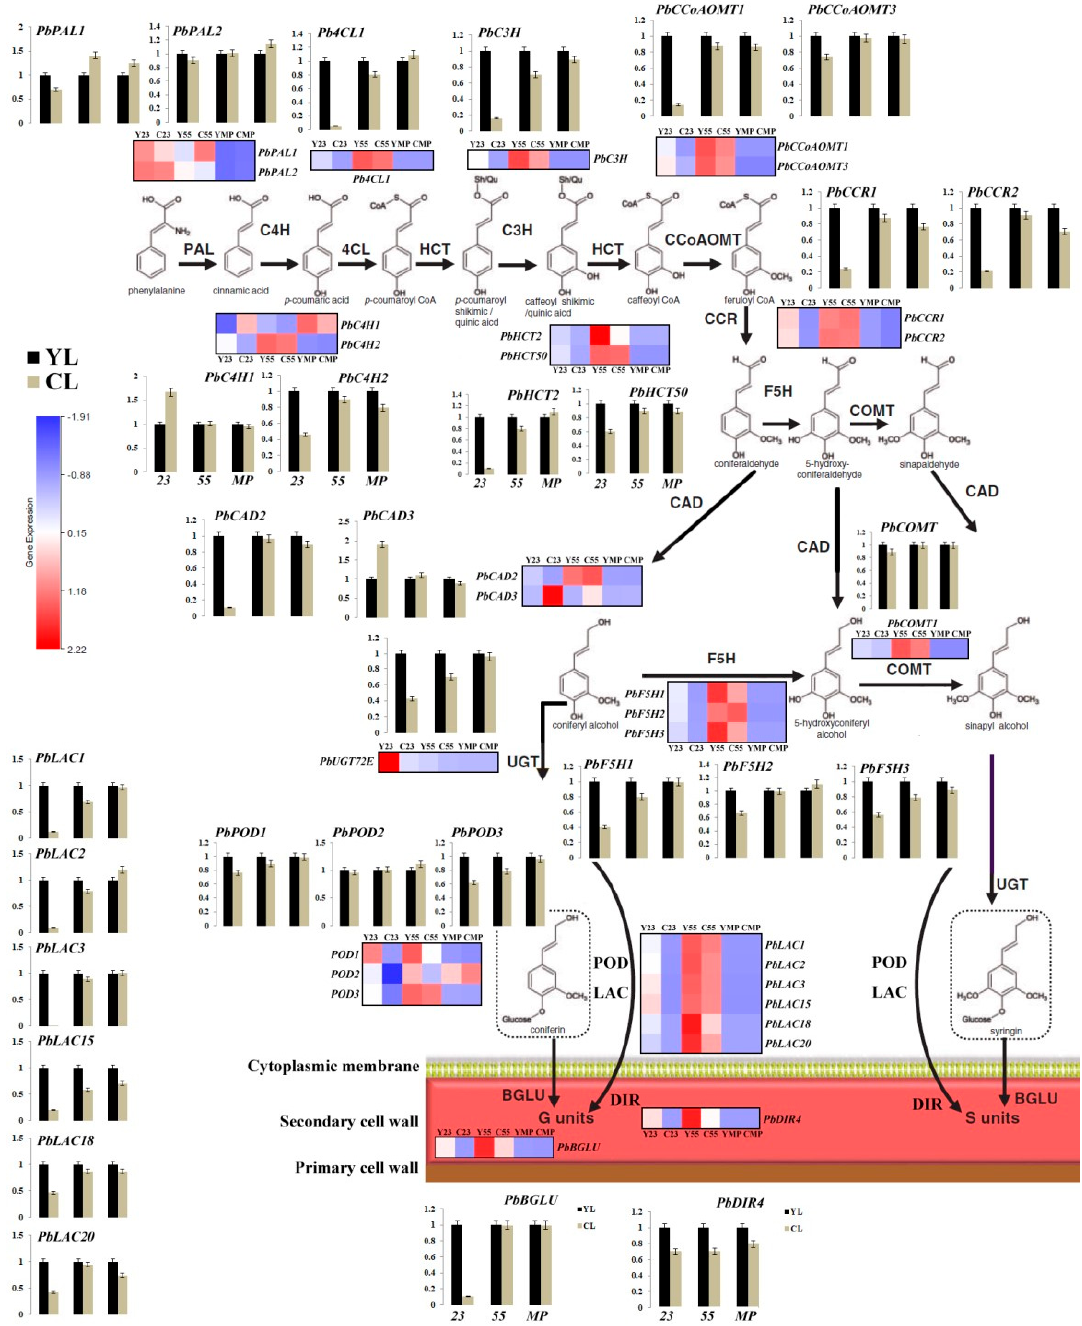
Figure 8. Expression profiling of structural genes involved in monolignol biosynthesis, transport × ‘Lianglizaosu’ ; CL: ‘Cuiguan” and polymerization. YL: ‘Yali’ ♂ × ‘Lianglizaosu’ ♀ ; CL: ‘Cuiguan’ ♂ × ‘Lianglizaosu’ ♀ ; C23: Fruit samples from CL at 23 DAF; C55: Fruit samples from CL at 55 DAF; CMP: Fruit samples from CL at